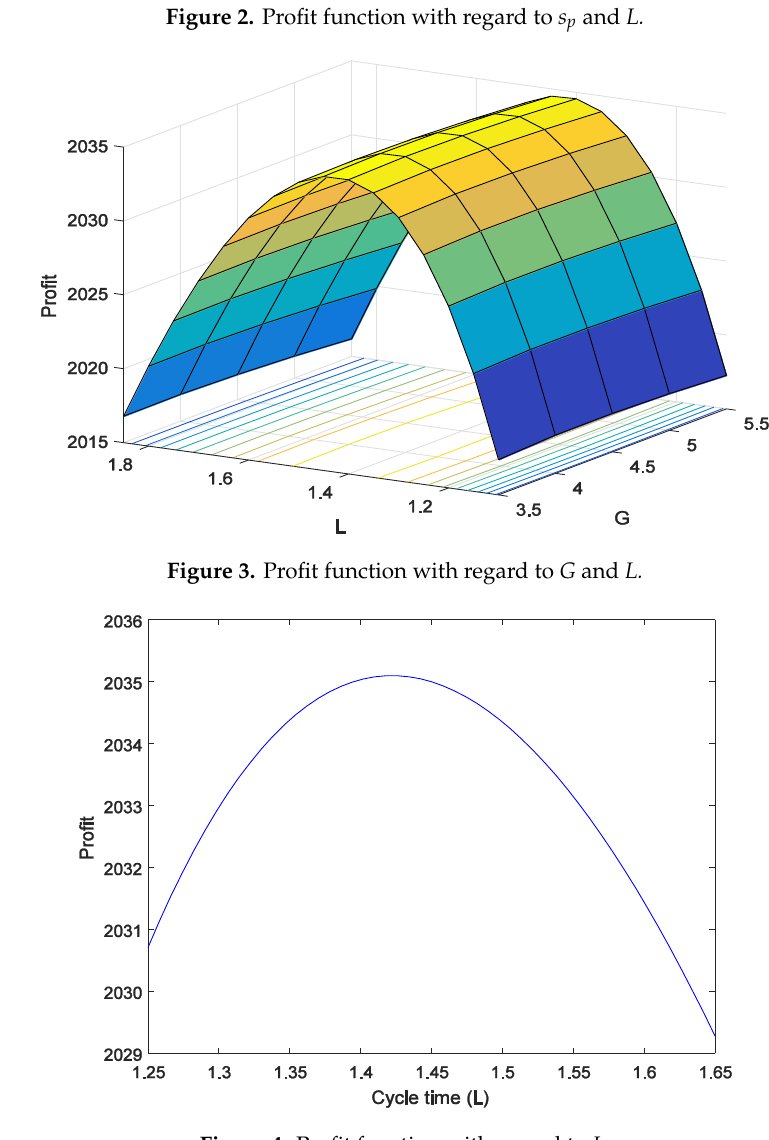
Figure 5. Profit function with regard to s p.